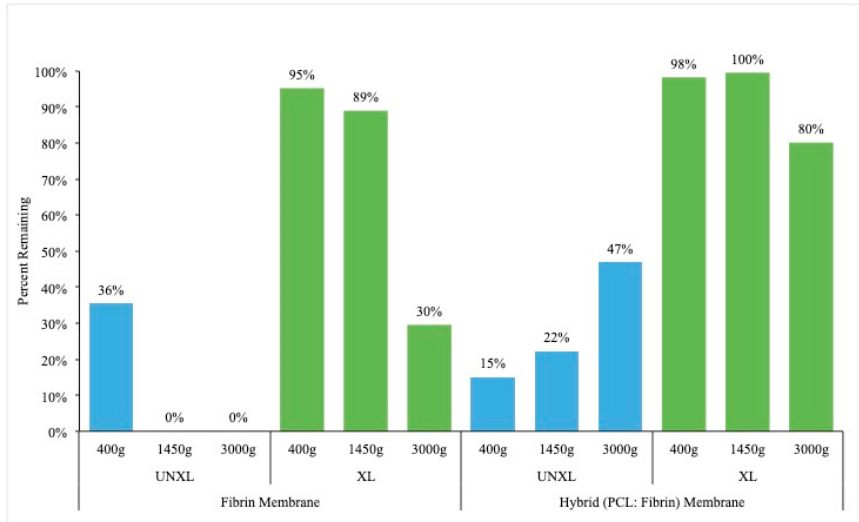
Figure 4. Effect of crosslinking on stability of membranes. Uncrossed fibrin matrices